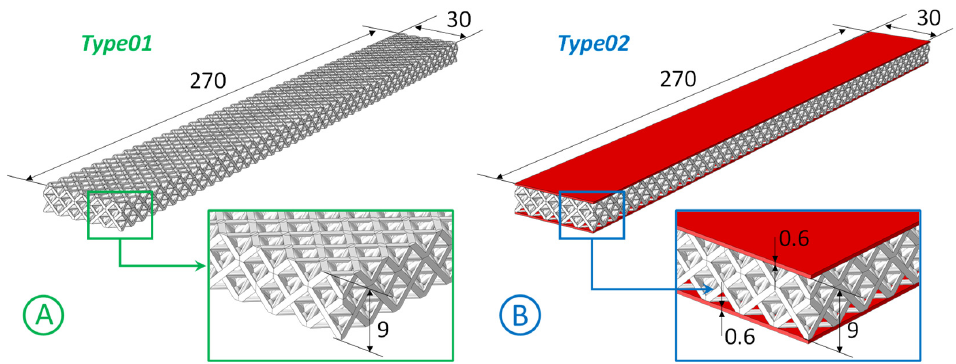
Figure 5. ( A ) Geometry of the lattice specimen without outer skin (type01); ( B ) Geometry of the lattice specimen with outer skins (type02).